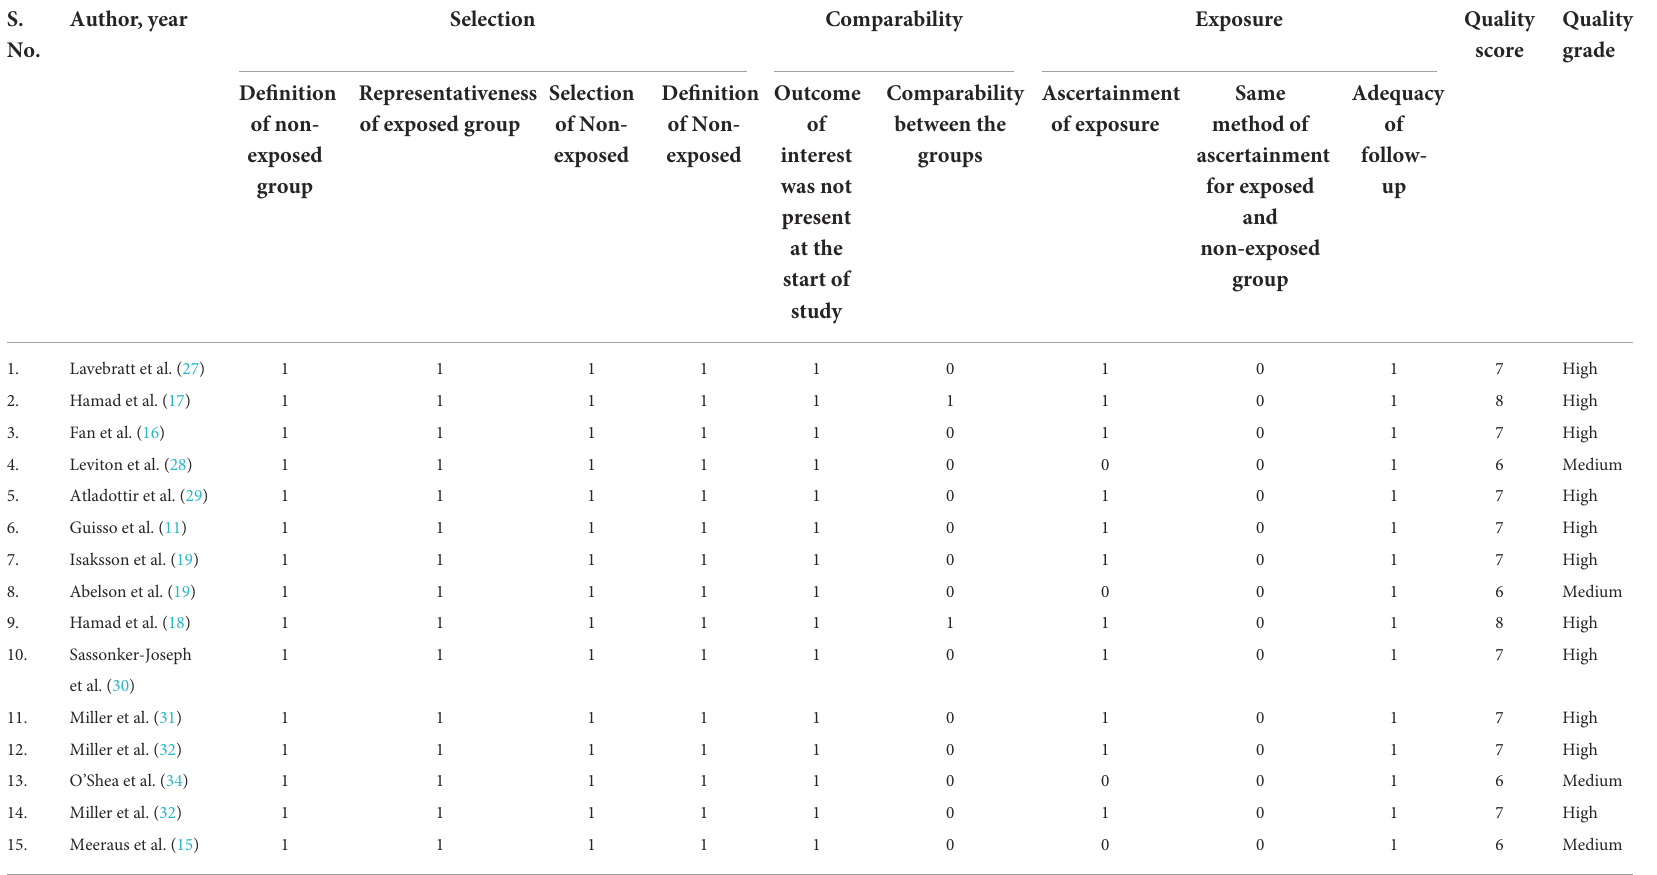
TABLE 2 Quality assessment of the included studies in the systematic review using the Newcastle Ottawa Scale.